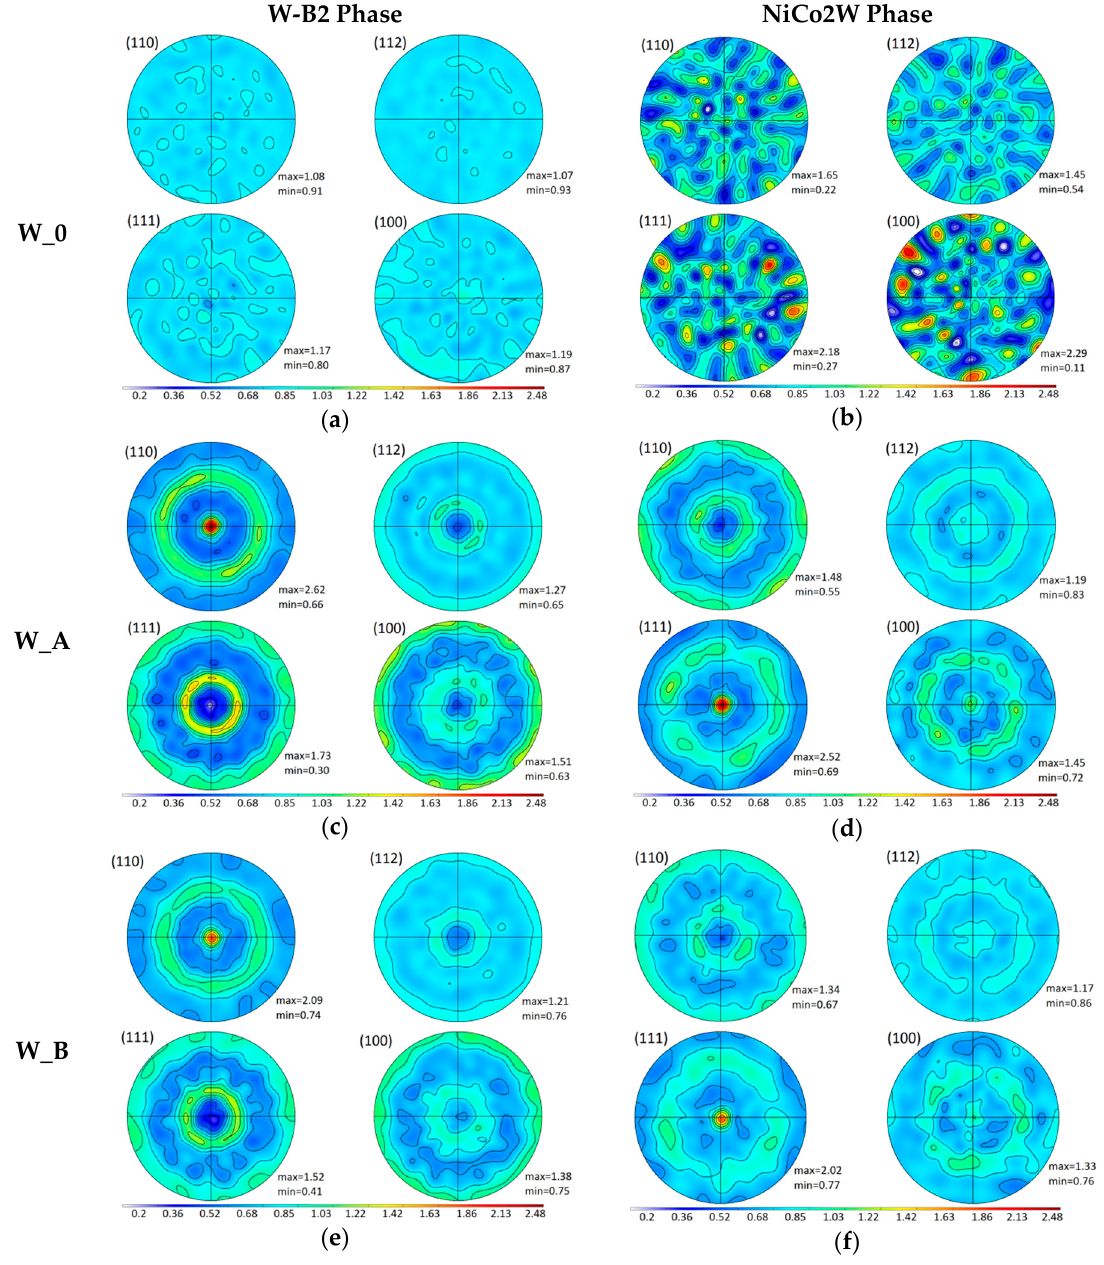
Figure 3. The measured pole figures for all samples (marked on the left, W_0 ( a , b ); W_A ( c , d ); W_B ( e , f )) and both phases (marked on the top, B2 ( a , c , e ); NiCo2W ( b , d , f )) and all measured reflections. The intensity scale is identical for all graphs. The swaging axis (z) was perpendicular to the figure plane.